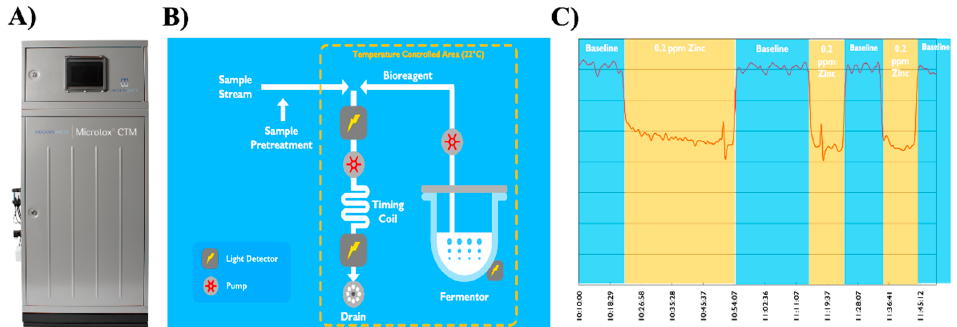
Figure 2. The Microtox ®® CTM (Continuous Toxicity Monitor, Modern Water Plc, London, UK) a commercial real-time water biomonitoring system based on a bioluminescent strain of bacteria Aliivibrio fischeri . ( A ) Overview of the device optimised to perform online monitoring in a continuously delivered stream of water sampled from reservoirs, water supply systems and water treatment plants; ( B ) Technical diagram depicting major components of the Microtox ®® CTM. Note an automated on-board fermenter that provides continuous culture of bioluminescent strain of bacteria Aliivibrio fischeri . The system can automatically perform one measurement every ten seconds for up to four weeks without any operator involvement, ( C ) Example response data with a reference toxicant (Zinc, 0.2 ppm). Source data provided by and used with permission from Modern Water Plc (London, UK, www.modernwater.com, accessed on 1 October